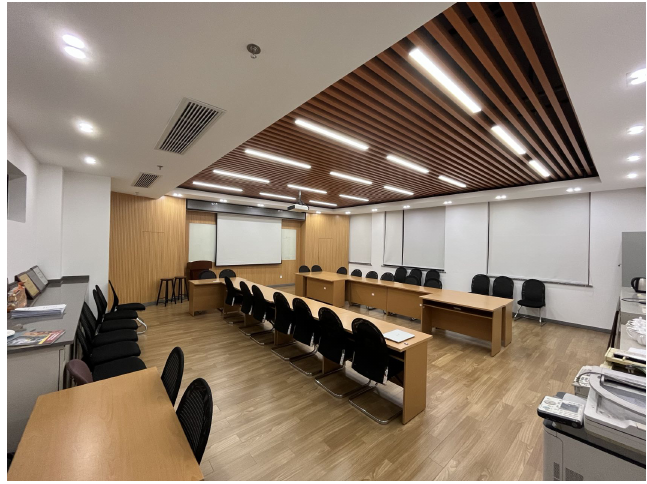
Figure 12. The scene of a conference